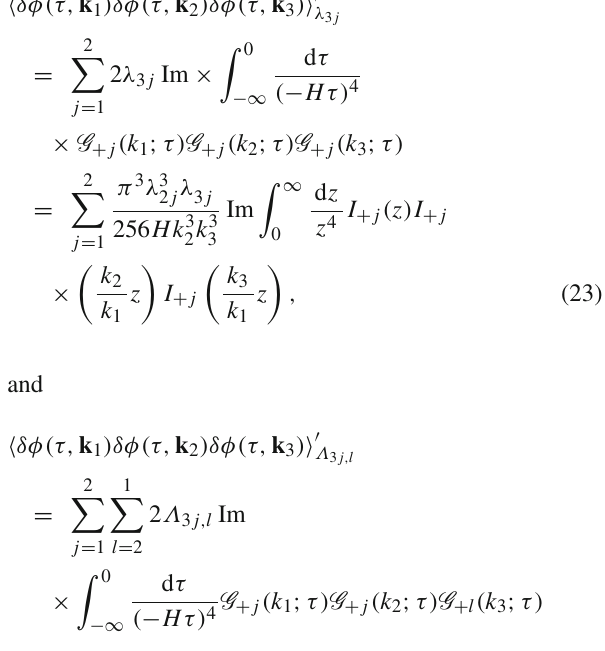
Fig. 8 In this diagram we want to examine the effects of changing the quantity of parameters ν j on the behaviour of power spectrum. We saw that if one consider different ranges for ν 1 and ν 2 it causes to increase the amount of power spectrum